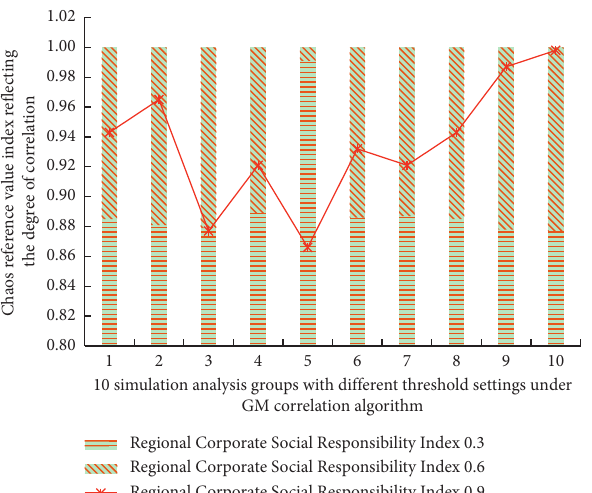
Figure 3: Analyze the results of 3 sets of known data under GM correlation algorithm for 10 times under different threshold settings.